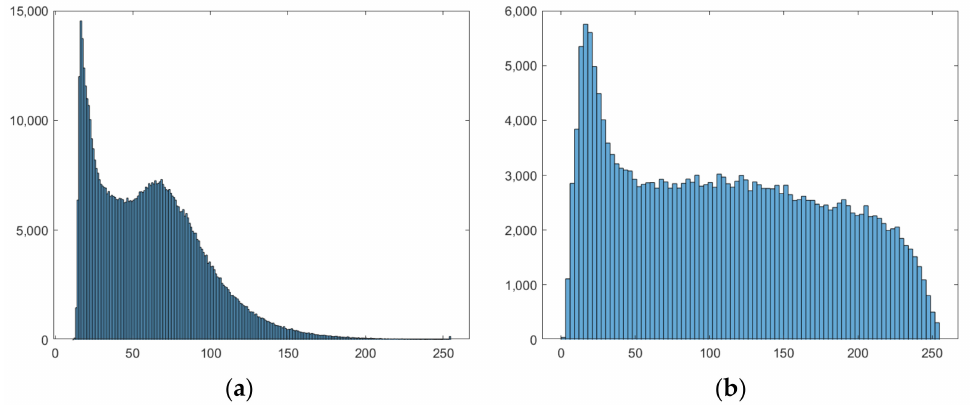
Figure 3. ( a ) Original image histogram; ( b ) adaptive histogram equalization applied on ( a